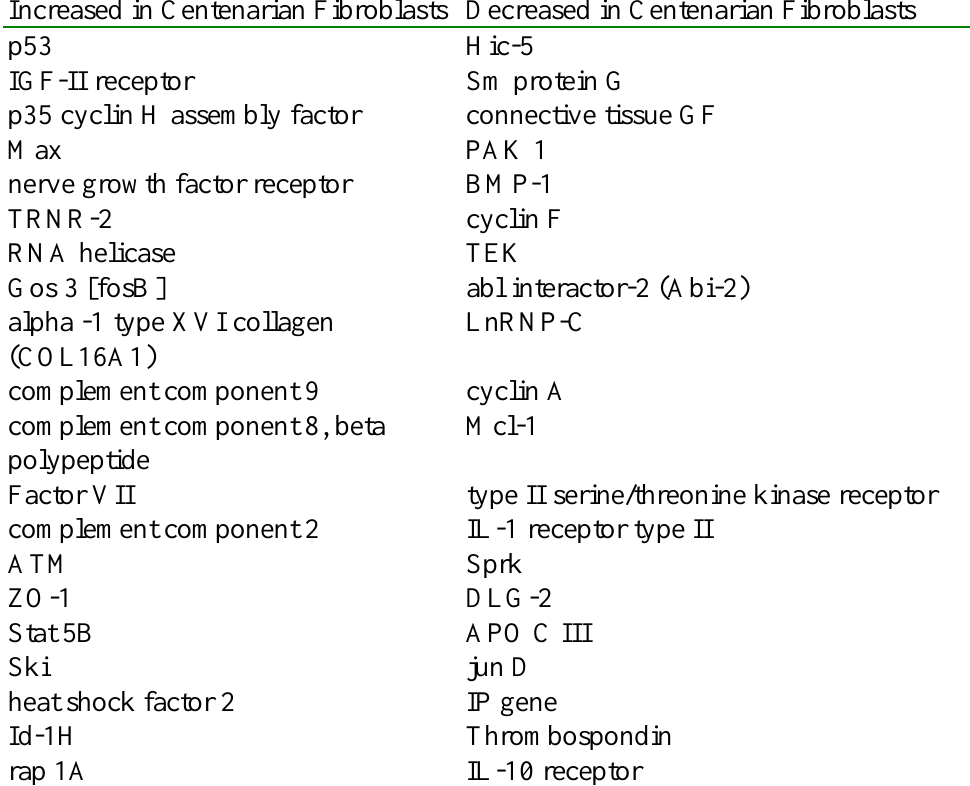
Table 1. Greatest change in relative intensity units of Centenarian vs.